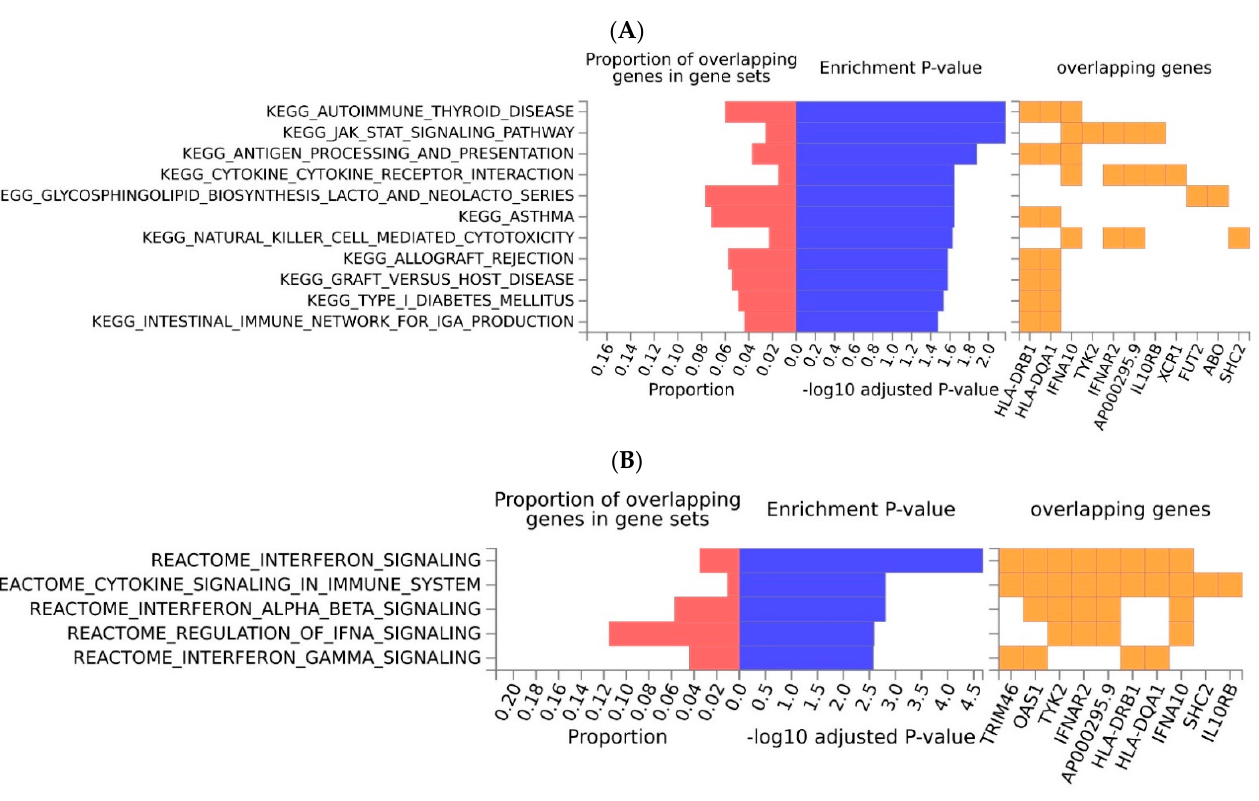
Figure 3. Enrichment analysis of COVID-19, regarding the KEGG pathways ( A ) and signaling pathways in the Reactome database ( B ). Pathways that are overrepresented in the gene set of interest are shown. Furthermore, only genes present in a given pathway are given. Overrepresentation of the gene set of interest (input genes), regarding the pathways was tested using the hypergeometric test against the pre − defined gene sets (background genes) obtained from Reactome or KEGG. Input genes that are overlapping in the pathway, the enrichment p -value and the proportion of the overlapping genes (input genes relative to the tested gene set) are shown. Source: FUMA .